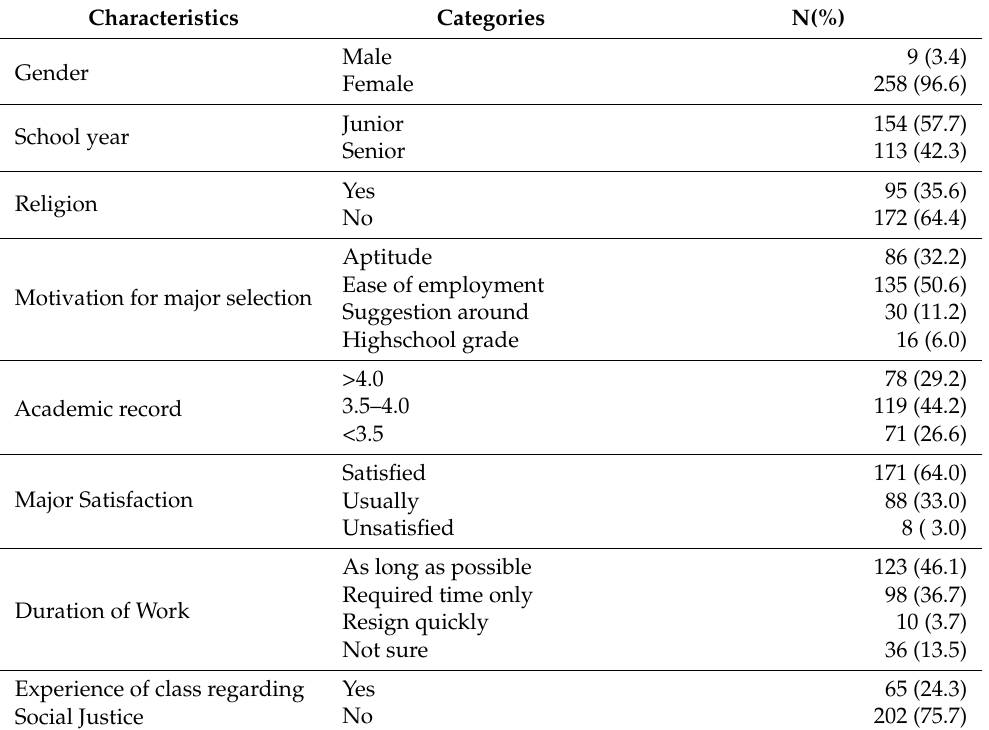
Table 1. Demographic Characteristics of Participants ( N =